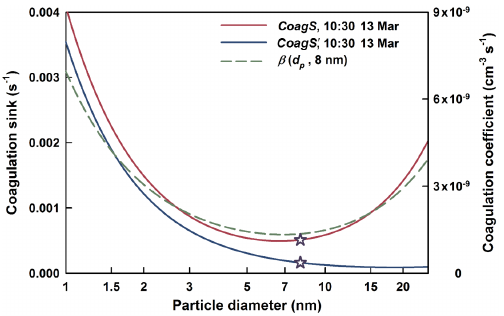
Figure B1. Coagulation coefficient and calculated coagulation sink during a typical NPF event. CoagS and CoagS (cid:48) are defined in Eqs. (B7) and (B8), respectively, and d m in this figure is treated as a variable rather than a constant value. The upper and lower stars denote CoagS (cid:48) and CoagS 8nm , which are used in the second 8nm term on the RHS of Eqs. (5) and (6), respectively, to approximate CoagSnk.